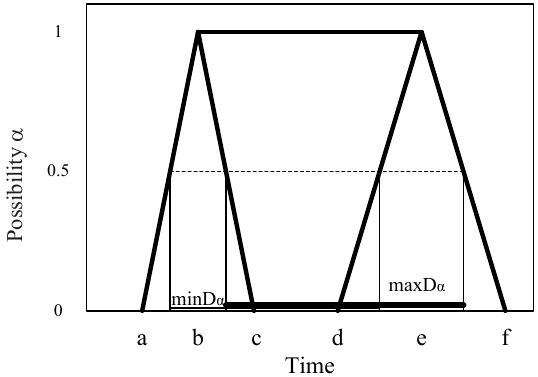
c’b’0 a b a’ c Fig. 3. Comparison of fuzzy set A  and B 